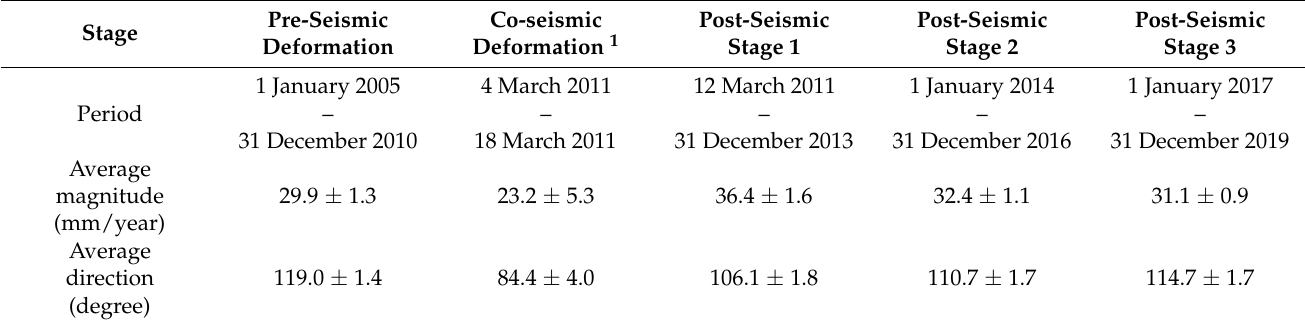
Table 1. Average velocity magnitude and direction in the five